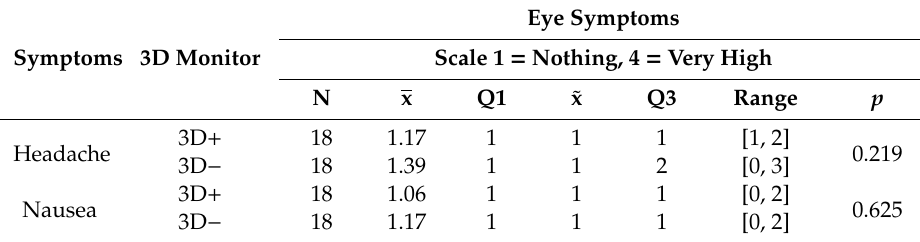
Table 5. Eye symptoms that participants experienced during the operation by using each system. Eye Symptoms Symptoms 3D Monitor Scale 0 = Nothing, 10 = Extremely High N x Q1 ˜ x Q3 Range p 18 1.64 0.5 0.75 Eye strain 3D + 18 1.11 0 0 2.5 [0, 5] Eye burn 0.547 3D − 18 1.25 0 0.5 2.75 [0,